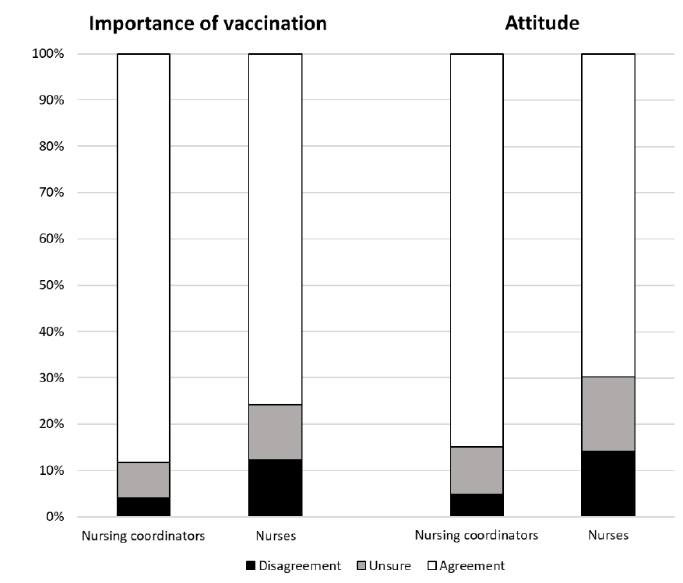
Figure 2. Frequency distribution (percentages) of answers on the “importance” and the “attitude” categories by qualification.